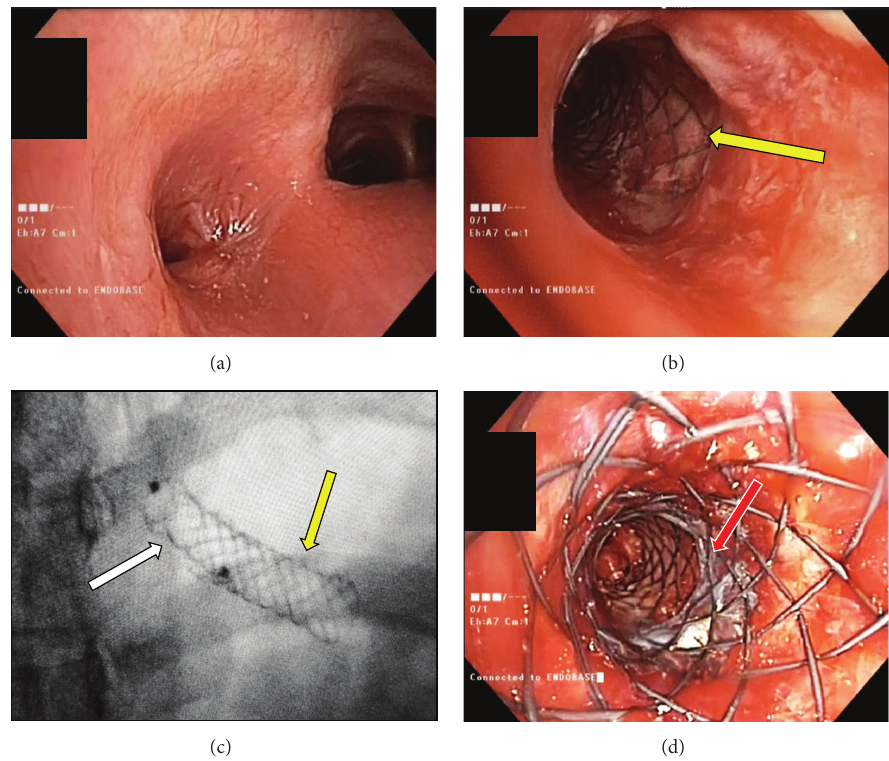
Figure 2: (a) Endoscopic view of the left main bronchus stenosis. The stenosis was of a mixed origin: malignant and postradiotherapy fibrotic stricture. (b) After recanalization of the main left bronchus, the previously inserted stent is visualized (yellow arrow). (c) Fluoroscopic view of the two stents positioned in the left main bronchus: the proximal and newly inserted stent (white arrow) and the previous distal stent (yellow arrow). (d) Final endoscopic view showing the junction between the two stents (red